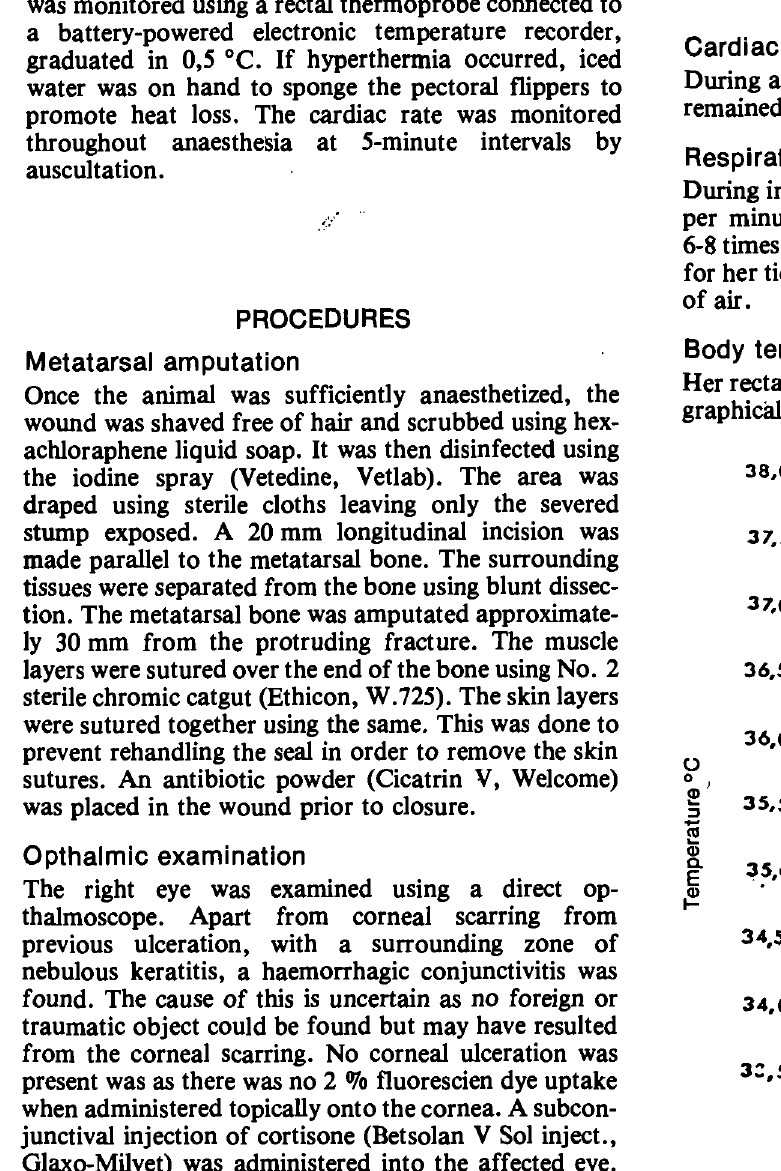
Fig. 1: Graphic representation to the body temperature decline observed during anaesthesia and surgery in a Cape Fur